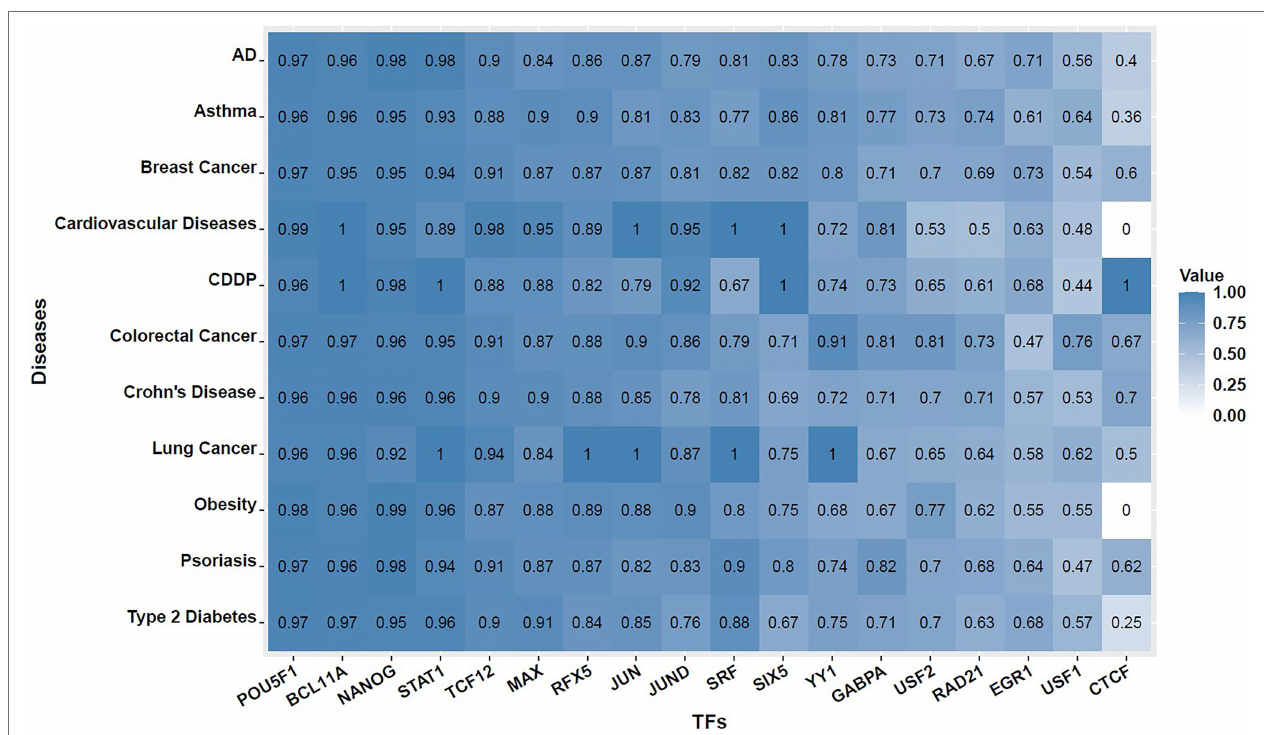
FIGURE 2 | Heat maps showing percentage of discordant SNVs across 18 TFs and 11 complex diseases. That is, among all SNVs that overlap with putative TF binding sites identified by PWM at GWAS-identified disease loci, what proportion of them has insignificant deltaSVM scores. The value shown inside each cell is the percentage of discordant SNVs found for the TF and disease